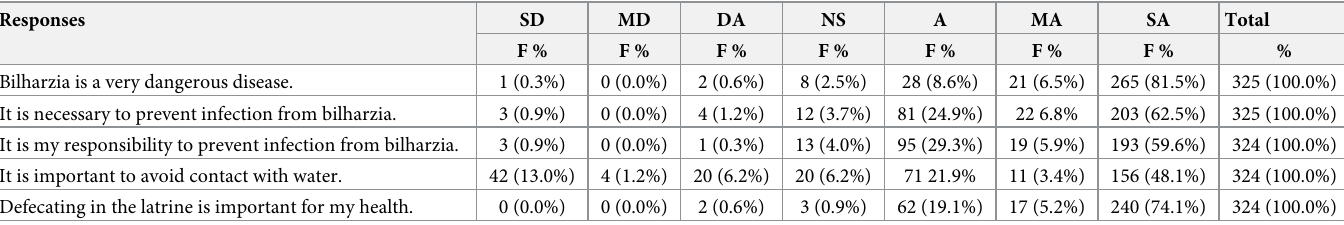
Table 4. Respondents’ attitudes regarding schistosomiasis. Responses